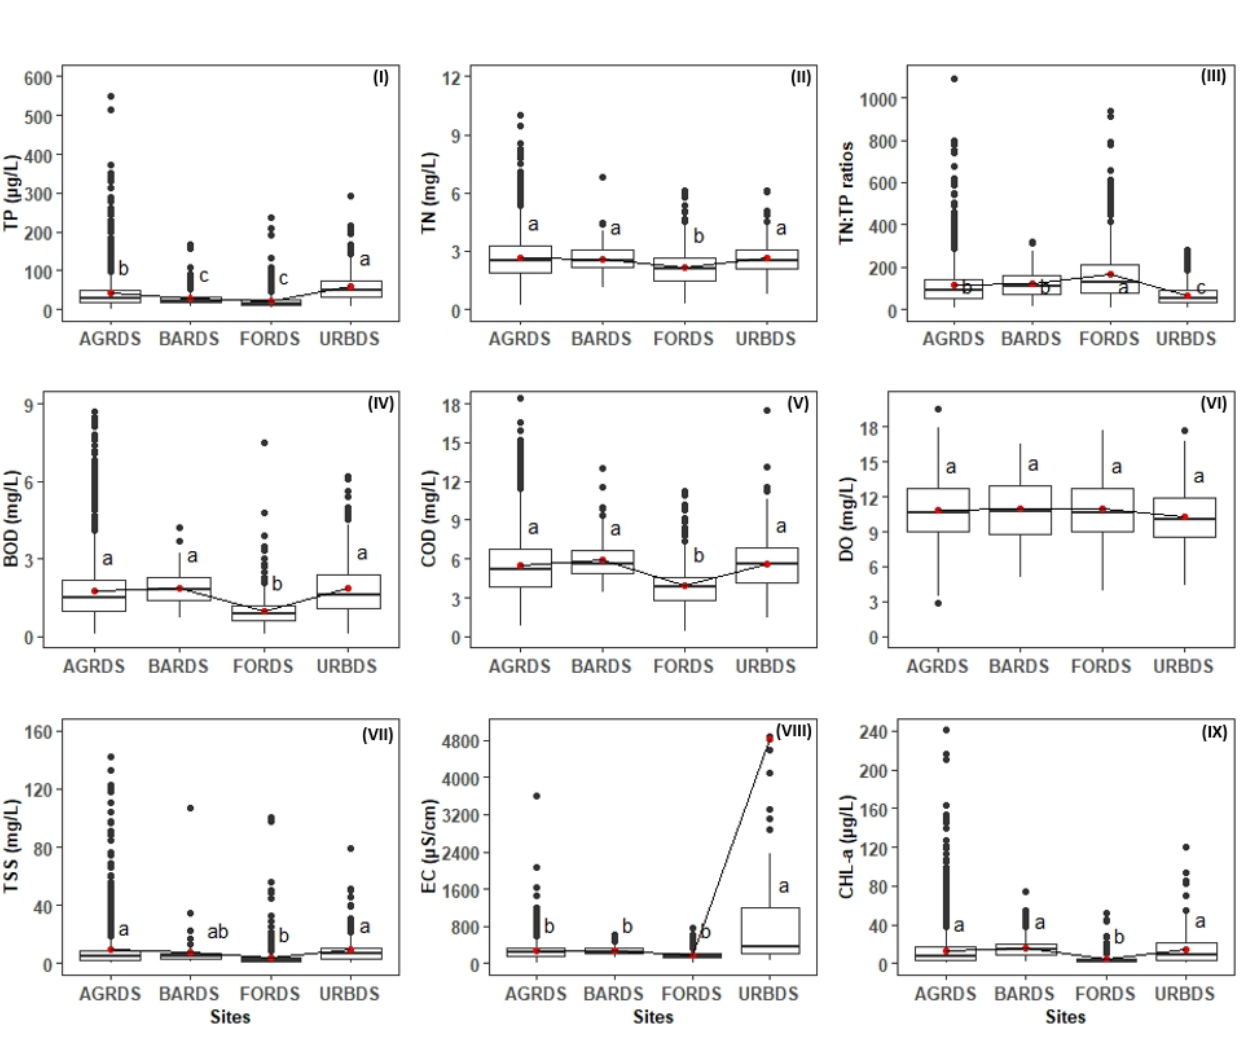
Figure 3. Land cover-dominated site variations in water quality variables in the Nakdong River